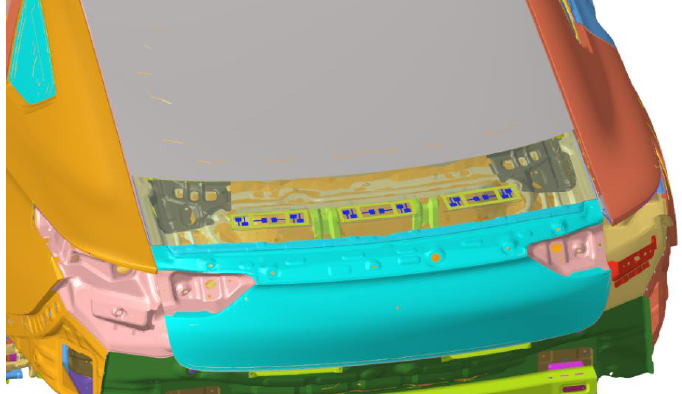
Figure 18. Acoustic metamaterial finite element model attached to the vehicle. The same road noise excitation signal and excitation point positions as in Section 3 were used to conduct road noise simulation analysis and vibration response analysis of the plate metal parts of the tailgate before and after the attaching of the acoustic–solid coupled finite element model. The simulation results are shown in Figures 19–22. By comparing the data before and after the acoustic metamaterial, the vibration and noise reduction effect of the acoustic metamaterial was verified.